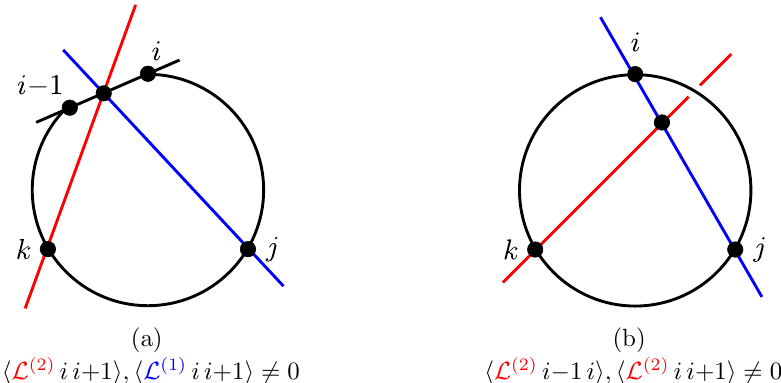
Figure 5. Two valid double relaxations of (cid:12)gure 3. The other two possibilities are obtained by taking i ! i +1 in (a) or L (2) ! L (1) and j $ k in